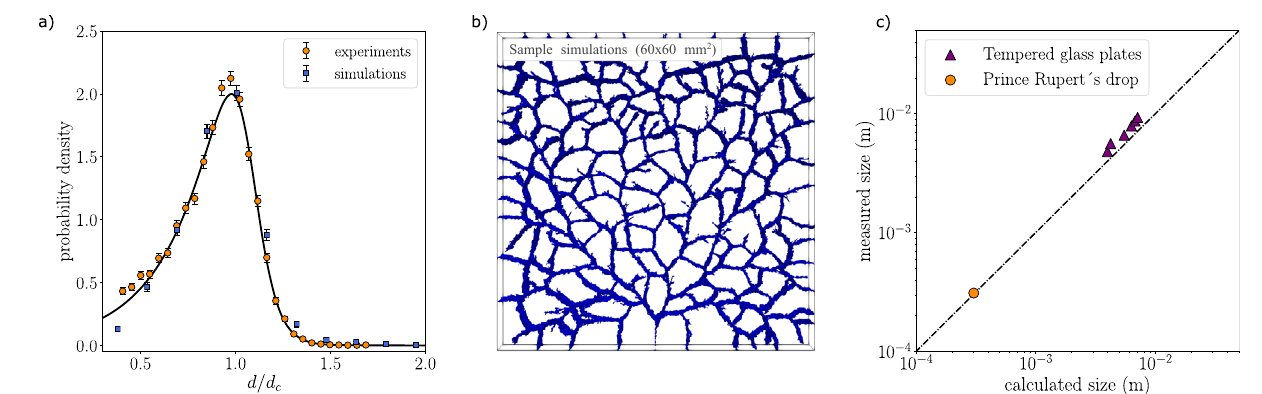
Fig. 3 Predictions and measurements. a Rescaled fragment size distributions of the tempered glass plates (orange circles) and data from fi nite-element simulations 39 (blue squares). Error bars indicate one SD. The truncated exponential can be fi tted with a generalized logistic distribution (solid line). b Crack pattern of a simulated fracture in a tempered plate of 60 mm × 60 mm. The fragmented plate shows a strong resemblance with the experimental plate (Fig. 1b). c Measured fragment sizes against calculated fragment sizes. For the experimental fragment sizes the cross-over length of the exponential distributions are used. For the tempered glass plates these are the loci of the maximum d c , while for the Prince Rupert ’ s drop this is the onset of a secondary fragmentation process at d = 310 μ m, i.e., the formation of “ dust ” particles. The predicted fragment sizes are calculated with Eq. (1) for the Prince Rupert ’ s drop and Eq. (2) for the tempered glass plates. Source data are provided as a Source Data fi